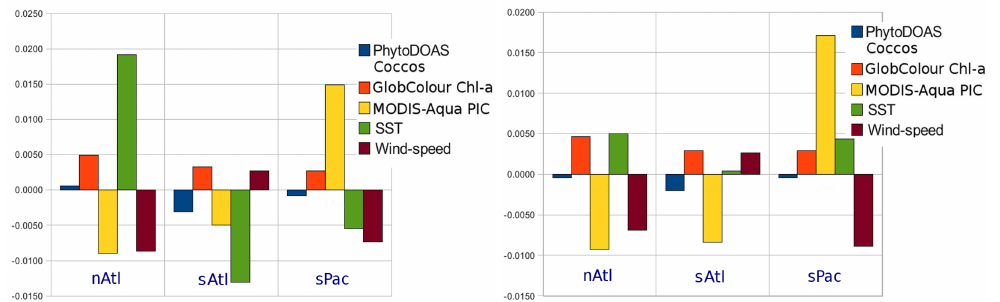
Fig. 10. Linear trends of five monitored parameters over eight years of data (2003 to 2010) for the biologically productive months. The left panel shows values of the simple trends , while the right panel shows values of the anomaly trends . Each panel contains the results of three study regions: nAtl (left), sAtl (middle) and sPac (right). In both approaches only the regional spring and summer months were considered: April to September for nAtl and September to March for sAtl and sPac. The chart does not include the MLD trends, due to their different ranges, which are much higher in order of magnitude.